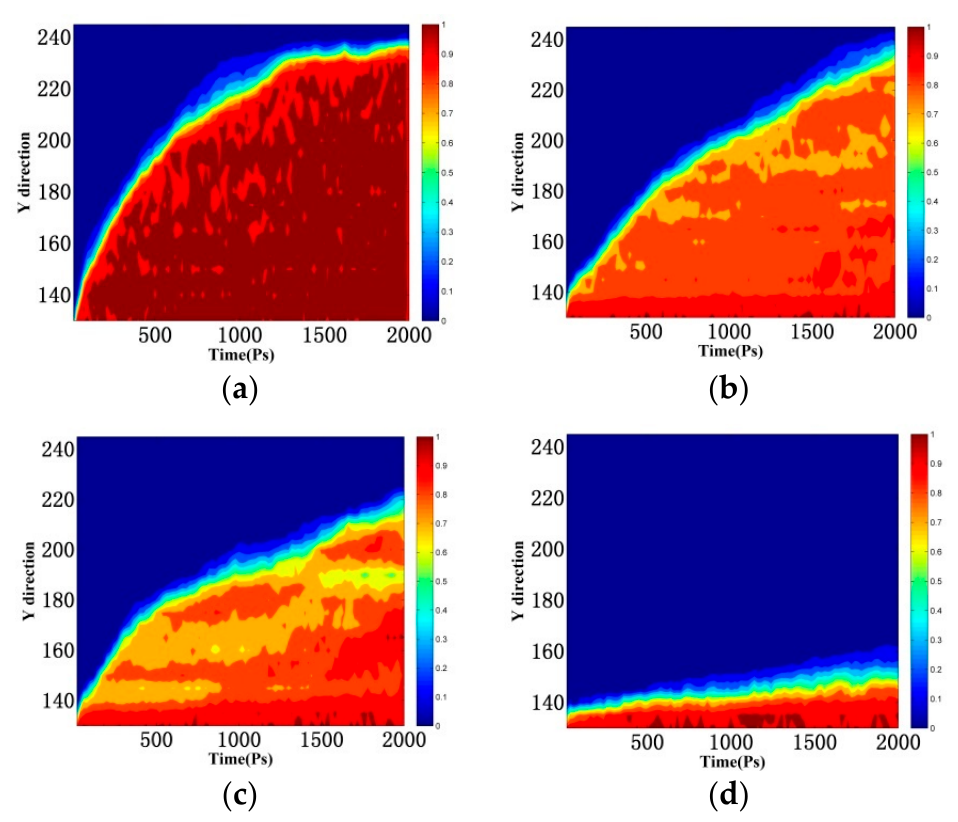
Figure 13. Concentration distribution of water molecules along the Y ‐ direction. ( a ) Blank; ( b ) MTES; ( c ) VTEO; ( d ) octyltriethoxysilane. (The unit in the Y and Z directions is Å).